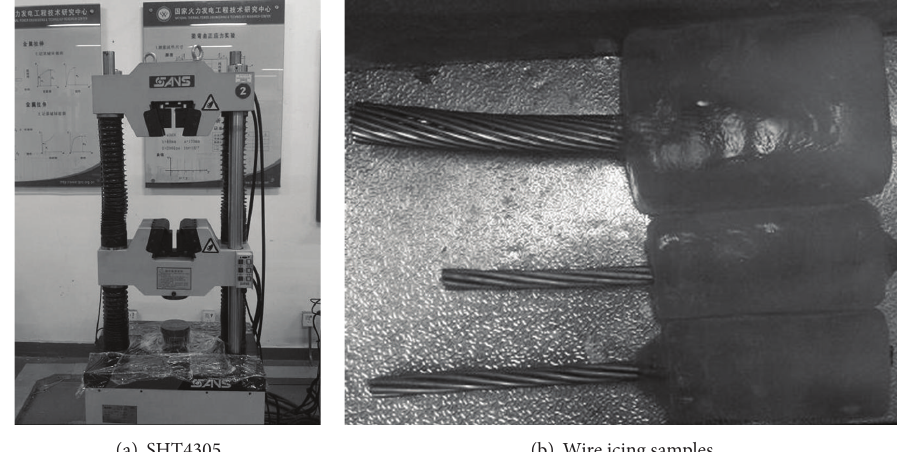
Figure 7: Experimental equipment and